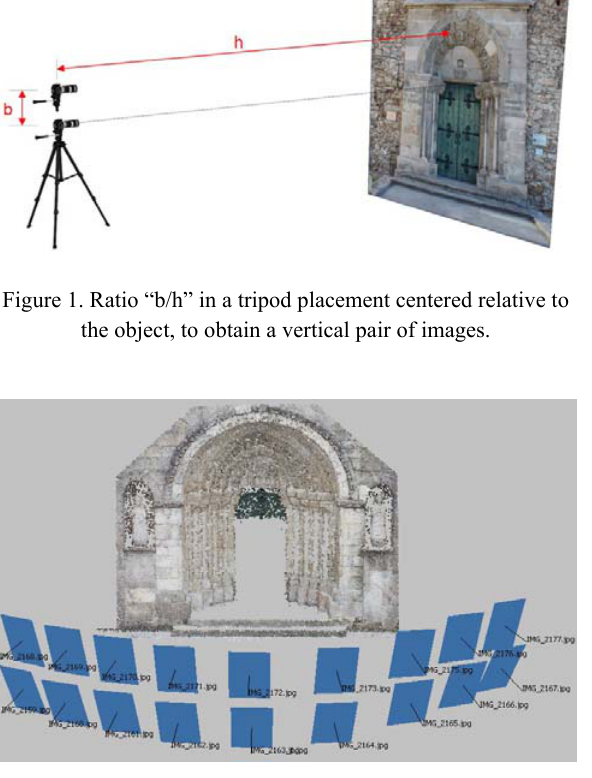
Figure 2. Sparse point cloud of the doorway with all the shootings needed to get both horizontal and vertical